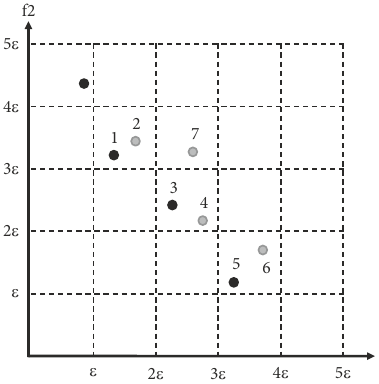
Figure 2. ε -dominance MOPSO external